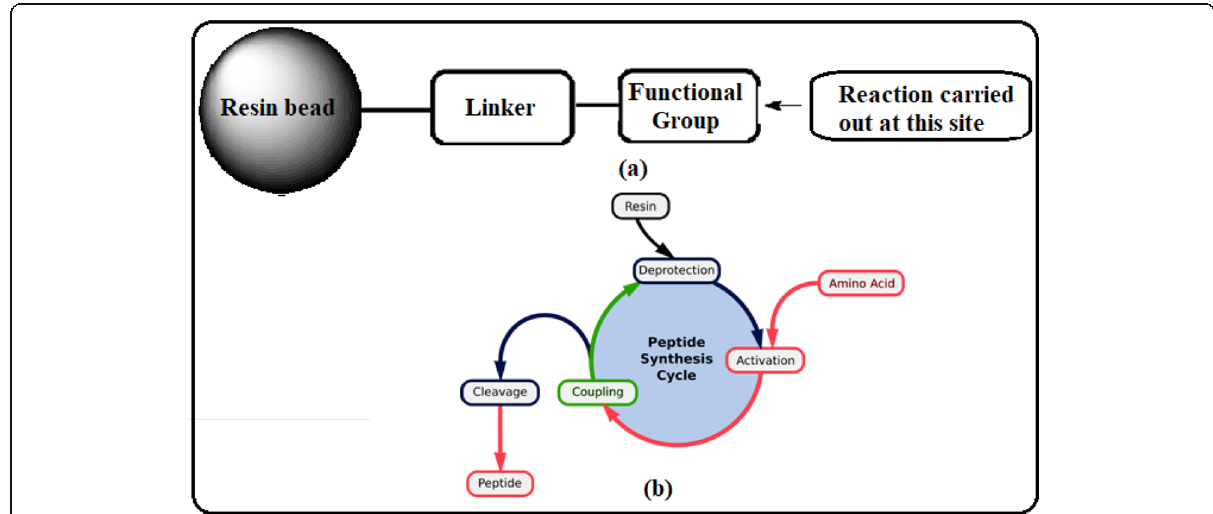
Fig. 3 a A schematic representation of solid-phase synthesis. b Peptide synthesis usingSolid-phase synthesis